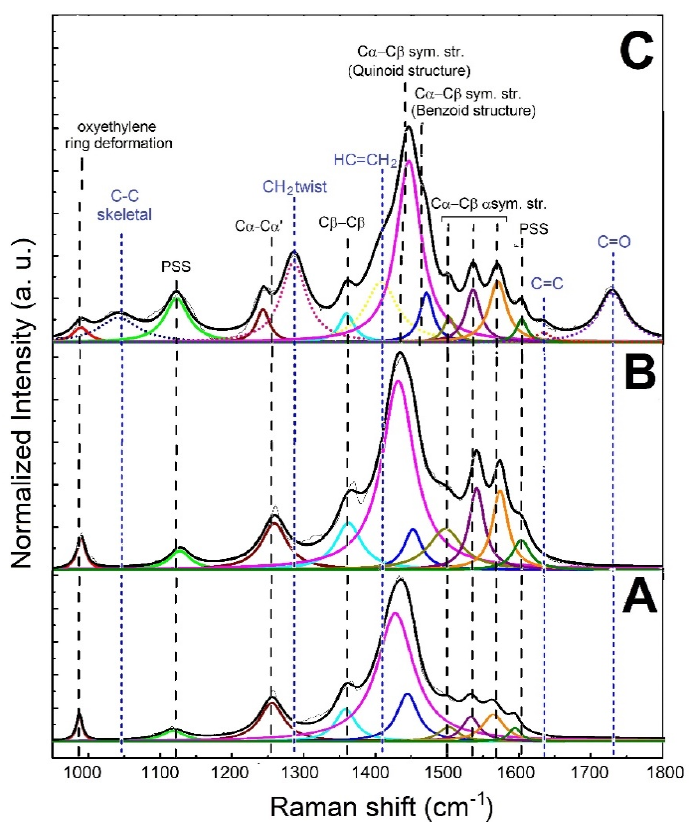
Figure 4. Raman spectra of ( A ) untreated PEDOT:PSS, ( B ) treated PEDOT:PSS and ( C ) printed PEGDA:PEDOT.